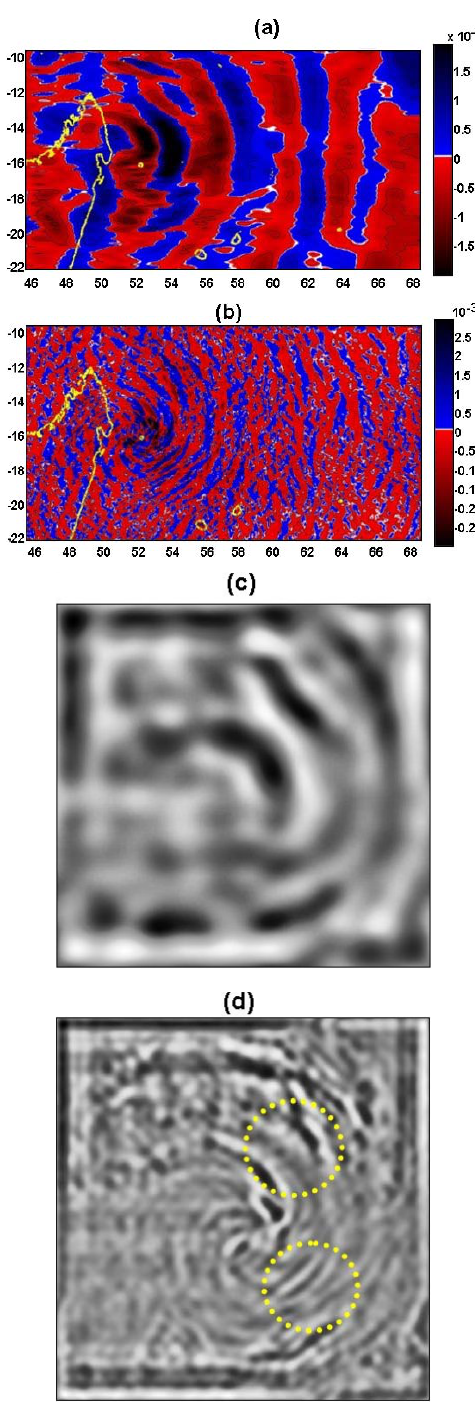
Fig. 11. Horizontal field of pressure perturbations at 20km altitude on 16 February 2008 at 12:00UTC for horizontal wavelengths be- tween (a) 200 and 800km, (b) < 200km. A yellow dot indicates the location of the TC eye. Binary filtered images using bidimen- sional FFT applied on the left square regions of images (a) and (b) for modes with horizontal wavelengths of (c) 400–600km and (d) < 200km respectively. Yellow dotted circles show the presence of GW modes in the southeast and northeast